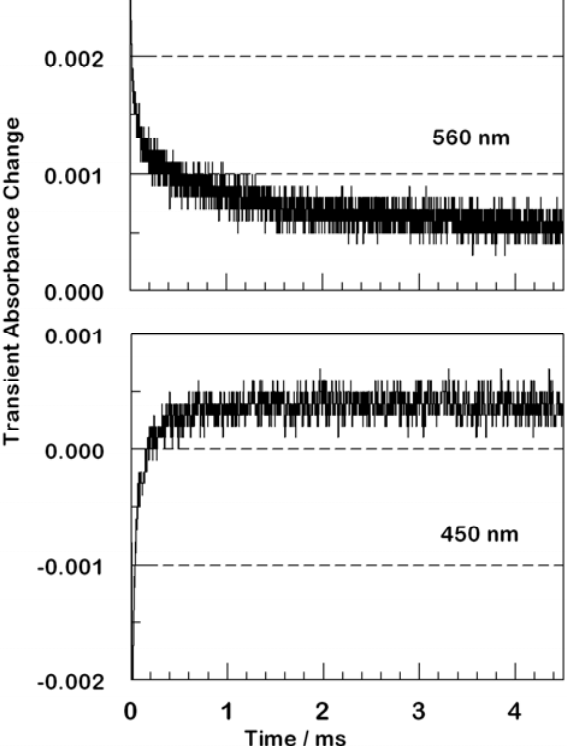
Figure 6. Transient kinetic absorption traces following nanosecond excitation of a D2 film. The upper panel had 355 nm excitation with 560 nm detection. The transient is absorptive at all times and does not return to baseline on this timescale. The lower panel had 355 nm excitation with 450 nm detection. At early times, bleaching characteristic of excited or oxidized ruthenium is observed, but this converts to absorption after tens to hundreds of microseconds. The absorption persists to much longer